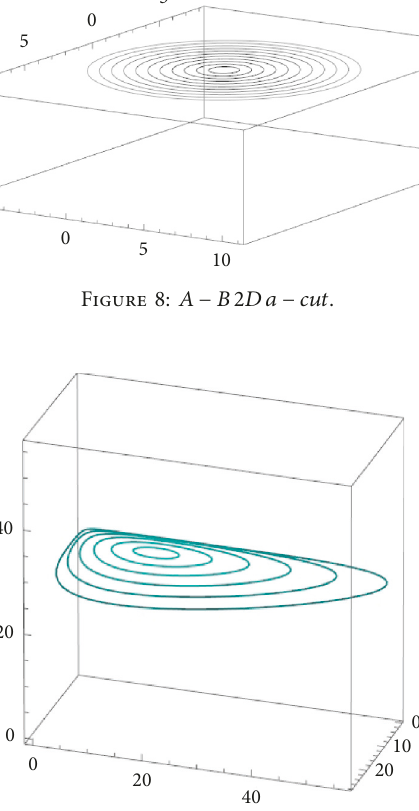
Figure 5: A 3 D half − cut .